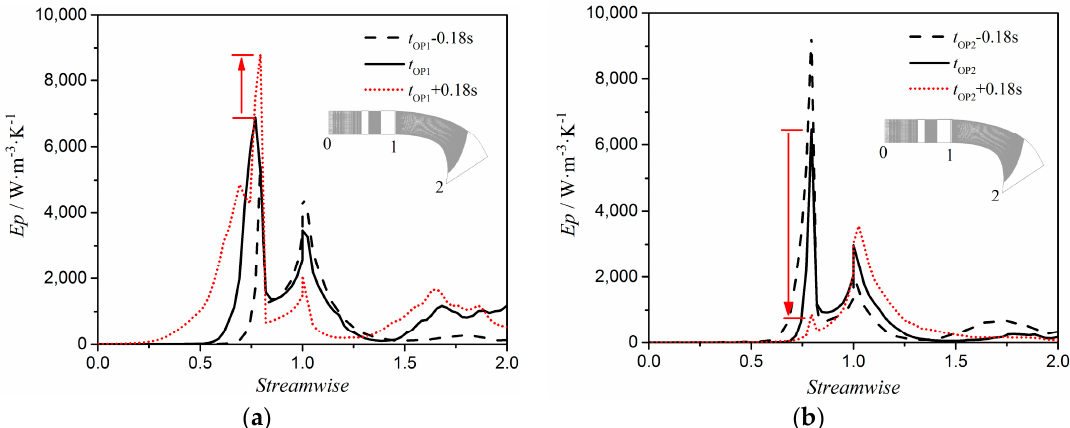
Figure 12. Changes of the distribution of entropy production rate Ep along the streamwise direction of flow passages at no-load points OP1 and OP2 for 15° GVO; ( a ) in the forward direction; ( b ) in the backward direction.